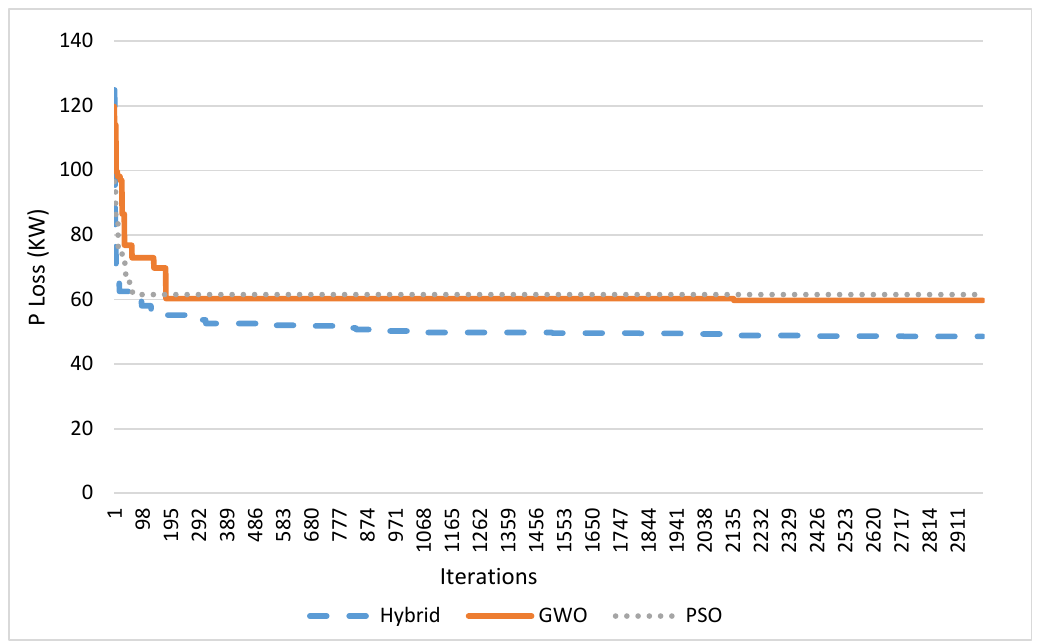
Figure 15. Voltage profile of the 78-bus system using the hybrid technique.